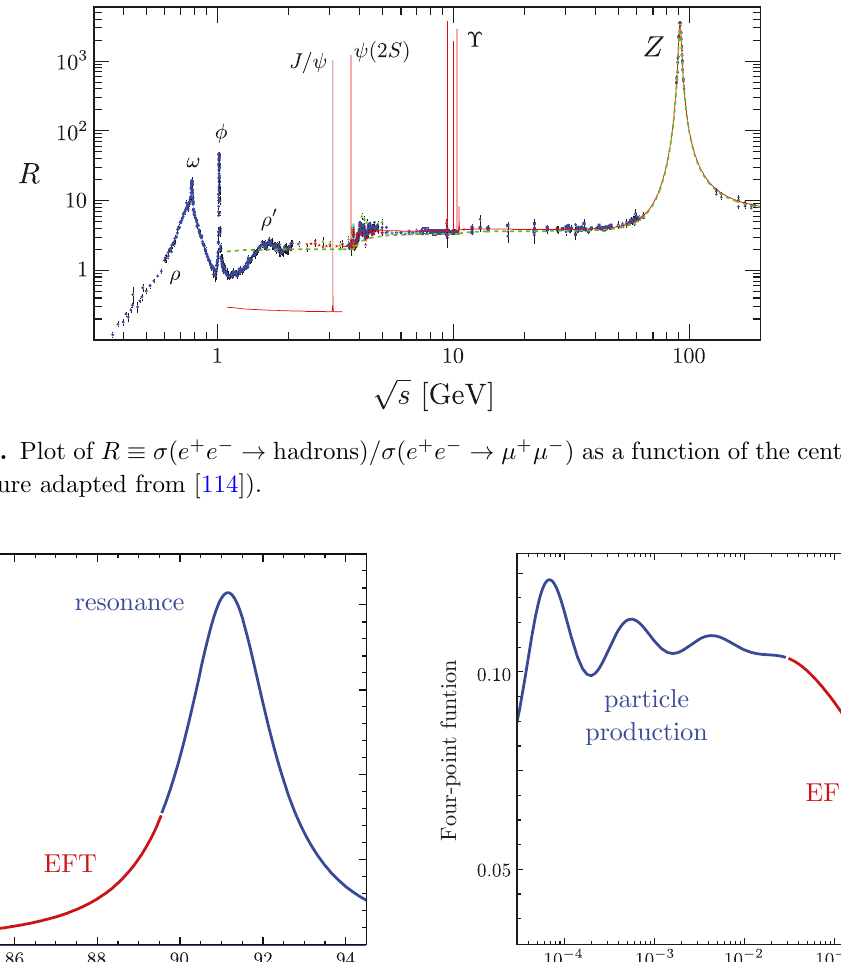
Figure 11. Left panel: shape of the Z resonance as measured by LEP. Right panel: example of scalar exchange, u (cid:0) 1 ^ F ( u; 0 : 5), for external particles with (cid:1) = 2 and an internal particle with (cid:22) = 3. Note that the four-point function has been rescaled by u (cid:0) 1 which visually enhances the e(cid:11)ect of the oscillations. In practice, the particle production e(cid:11)ect will be harder to observe than the EFT